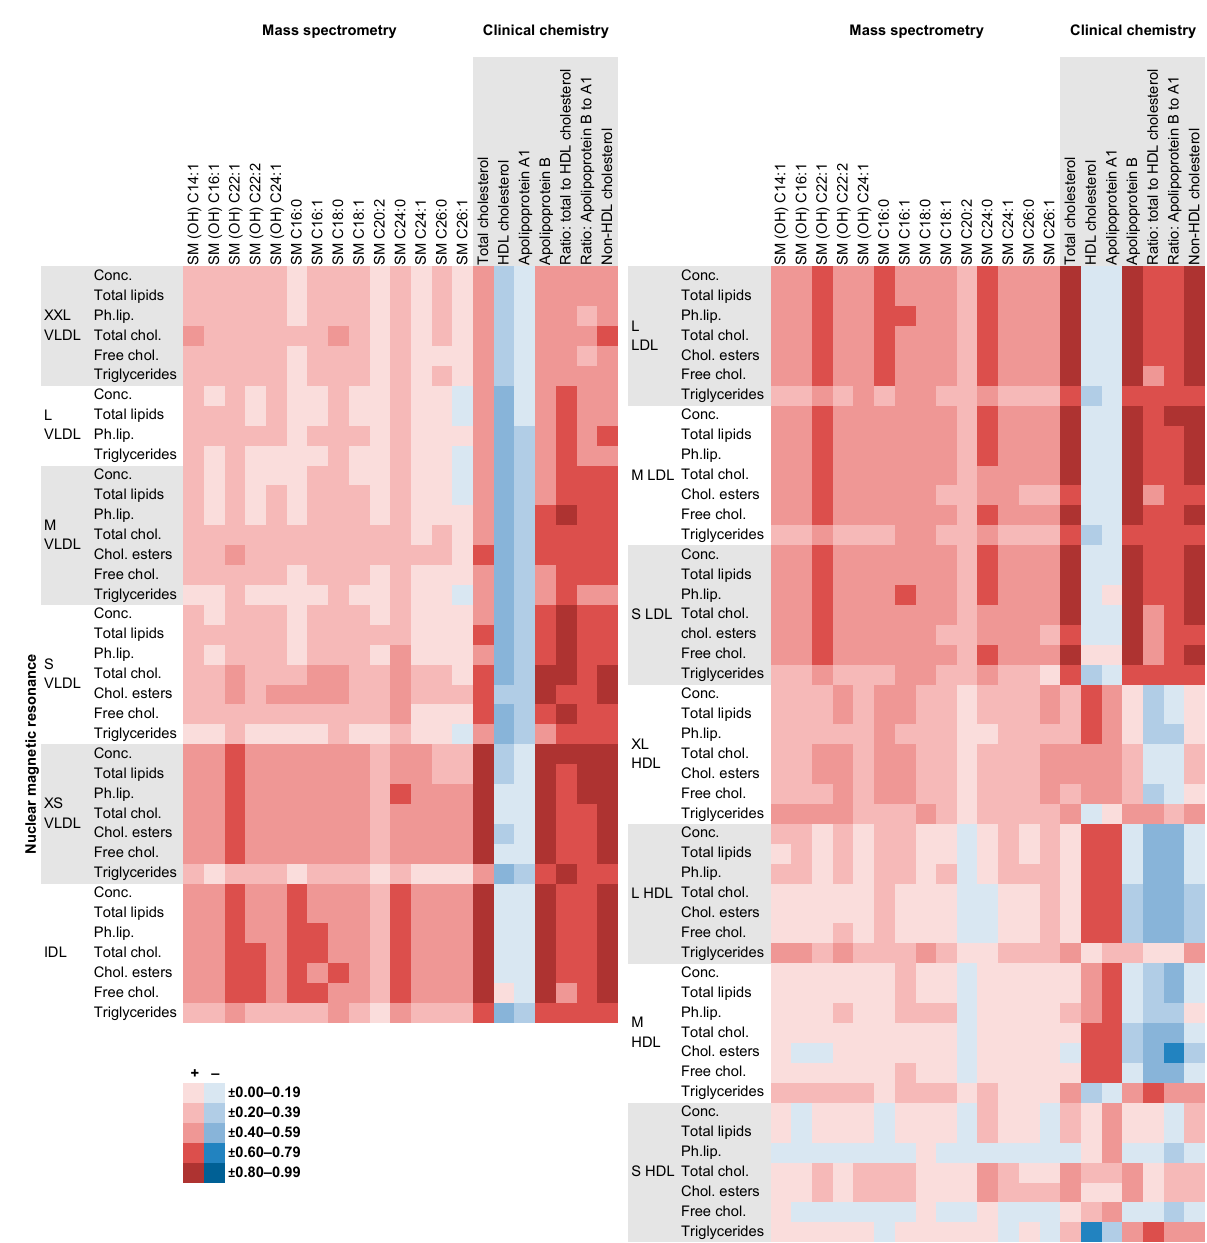
Figure 6. Correlations of NMR lipoproteins with clinical chemistry and MS sphingomyelins. Plasma sphingomyelin concentrations were measured using the mass spectrometry based Absolute IDQ ® p180 Kit (Biocrates Life Sciences AG, Innsbruck, Austria) [20]. ‘Cx:y’ denotes the number of carbon atoms and double bonds in the fatty acid side chain of the sphingomyelins (SM) and hydroxy-sphingomyelins [SM (OH)]. In serum, apolipoproteins were measured using an immunoturbimetric assay, total cholesterol was measured using an enzymatic assay and HDL cholesterol was measured directly [27]. Further details are seen in Table S7. Abbreviations: Chol., Cholesterol; Conc., concentration; HDL, high-density lipoprotein; IDL, intermediate-density lipoprotein; L, large; LDL, low-density lipoprotein; M, medium; NMR, nuclear magnetic resonance; Ph.lip., phospholipids; S, small; SM, sphingomyelin; SM (OH), hydroxyl-sphingomyelin; VLDL, very-low-density lipoprotein; XL, extra-large; XS, extra-small; XXL, chylomicrons and extremely